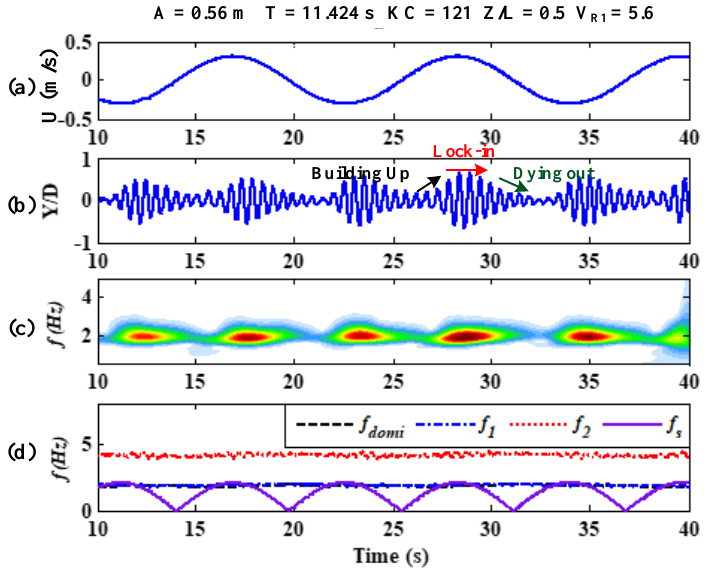
Figure 12. The time history of the VIV response and time–frequency distribution at Z / L = 0.5 for V R1 = 5.6 and KC = 121: ( a ) The forced motion velocity; ( b ) The VIV displacement response; ( c ) The time–frequency distribution of the VIV response; ( d ) The time-varying frequencies.